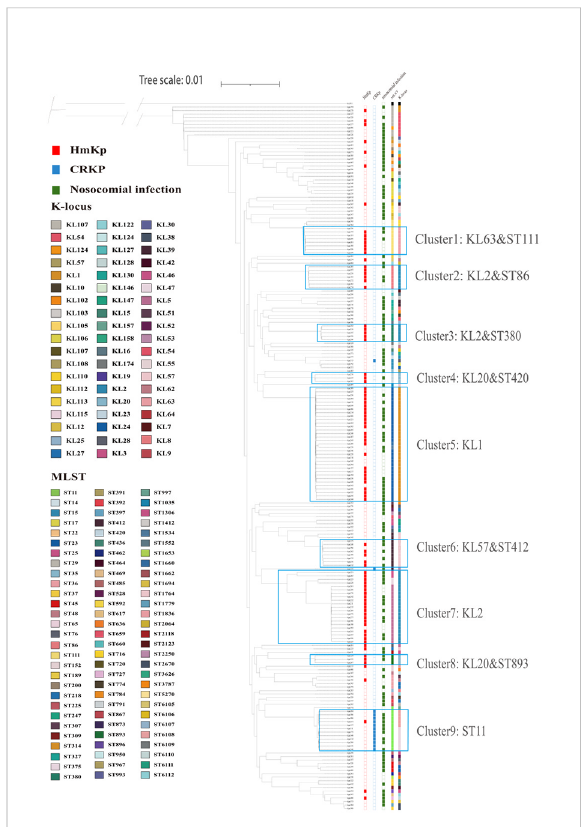
FIGURE 3 Core-gene phylogeny of 203 K . pneumoniae isolates. Isolates are annotated with datasets of HmKp, carbapenem-resistant isolates (CRKP), hospital-acquired infection, sequence types(ST) and capsular locus(KL) from left to right. Different STs and serotypes are designated by color, and the several ST clusters are marked. The most dominant clusters of HmKp and CRKP isolates are marked as: Cluster 1: KL63-ST111; Cluster 2: KL2- ST86; Cluster 3: KL2-ST380; Cluster 4: KL20-ST420; Cluster 5: KL1; Cluster 6: KL57-ST412; Cluster 7: KL2; Cluster 8: KL20- ST893; Cluster 9: